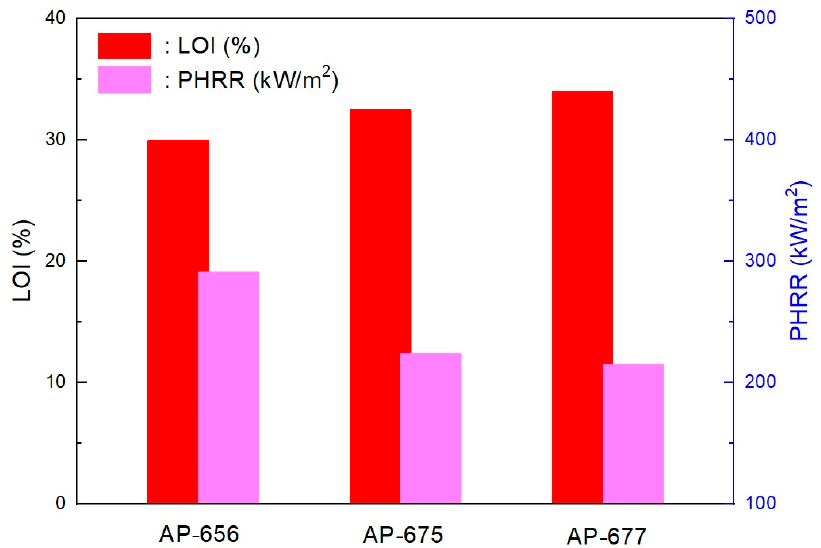
Figure 9. Relationships between LOI and PHRR in RP content formulations. RP content: AP ‐ 656 = 0, AP ‐ 675 = 3 phr and AP ‐ 677 = 5 phr.